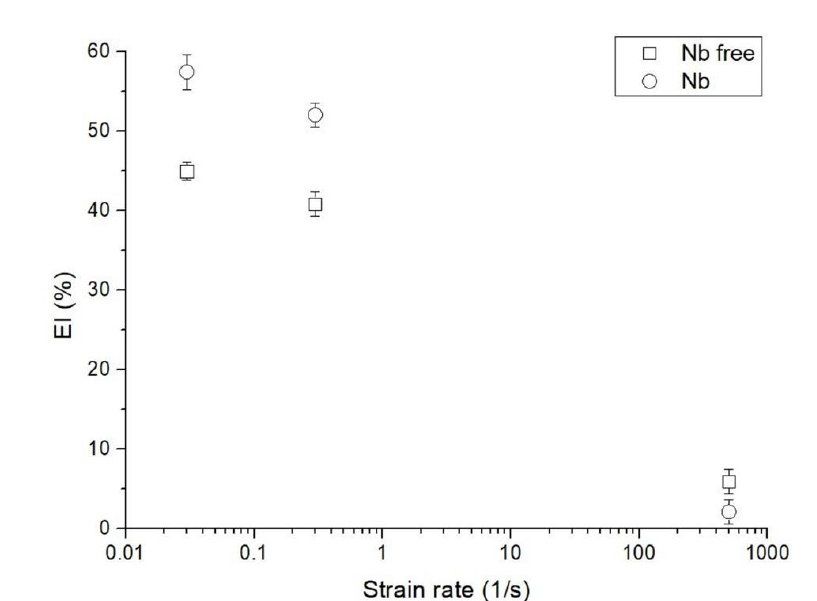
Figure 1: Embrittlement index for both the Nb and Nb free steel as function of the imposed strain